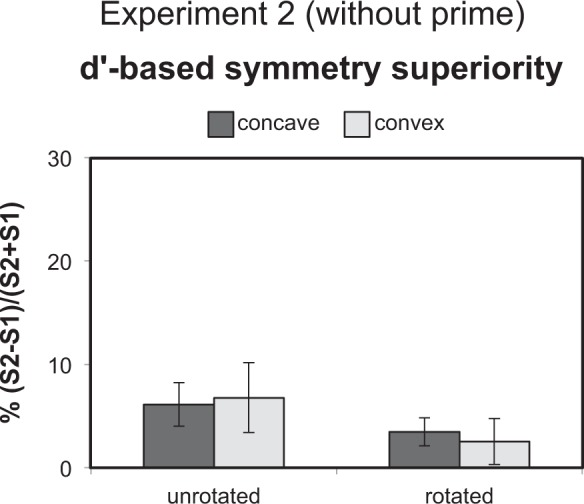
Experiment 2. Mean amounts of d′-based symmetry
superiority in the reduced Rotation × CCP design.